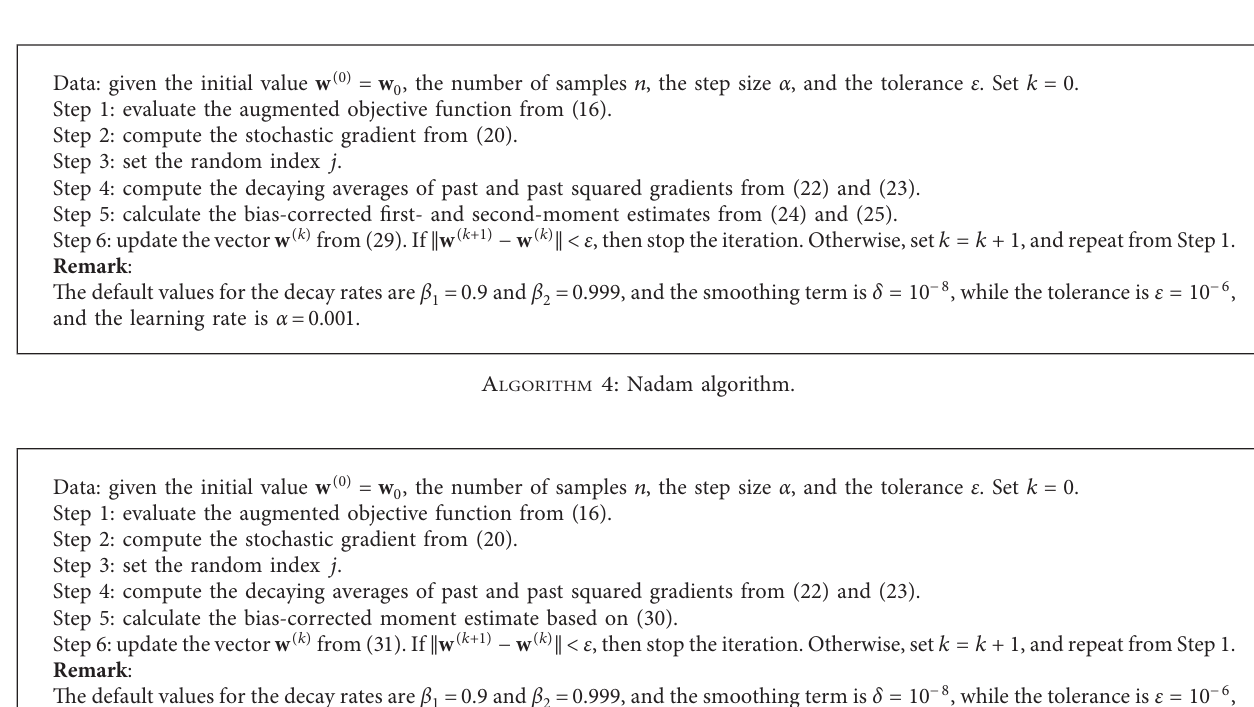
A LGORITHM 5: AMSGrad